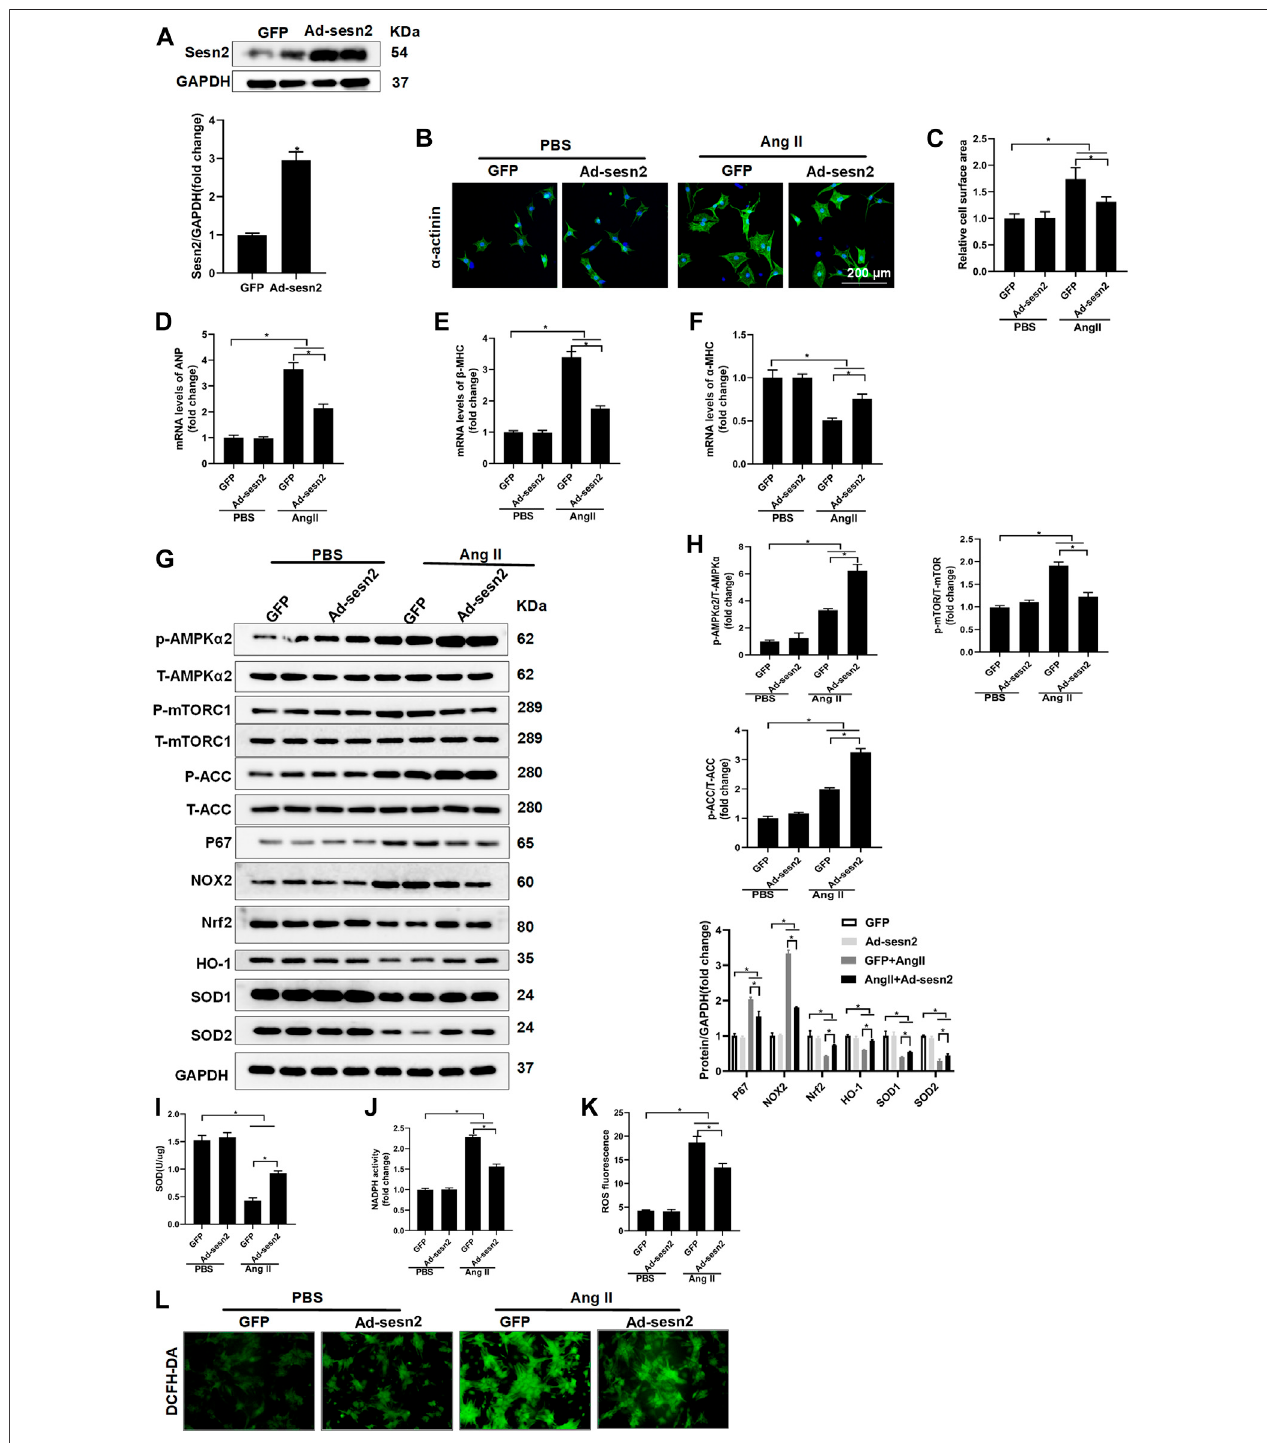
FIGURE5 | Sesn2 overexpression alleviatesAng II- induced cardiomyocyte hypertrophy in vitro. NRCMswere transfected withadenovirus (Ad)-Sesn2 or Ad-GFP for 24 h, and then treated with Ang II for another 48 h. (A) Examination of Sesn2 overexpression in cardiomyocytes ( n (cid:1) 6). (B,C) Representative images of α -actinin stainingand statisticalresults ofcell surfacearea ( n > 50cells per group). mRNAexpression of (D) ANP, (E) α -MHCand (F) β -MHC. (G) RepresentativeWesternblotsof thephosphorylatedandtotalproteinsofAMPK α 2,mTORC1,ACC,P67,NOX2,Nrf2,HO-1,SOD1,andSOD2inNRCMstransfectedwithAd-Sesn2orAd-GFPfor